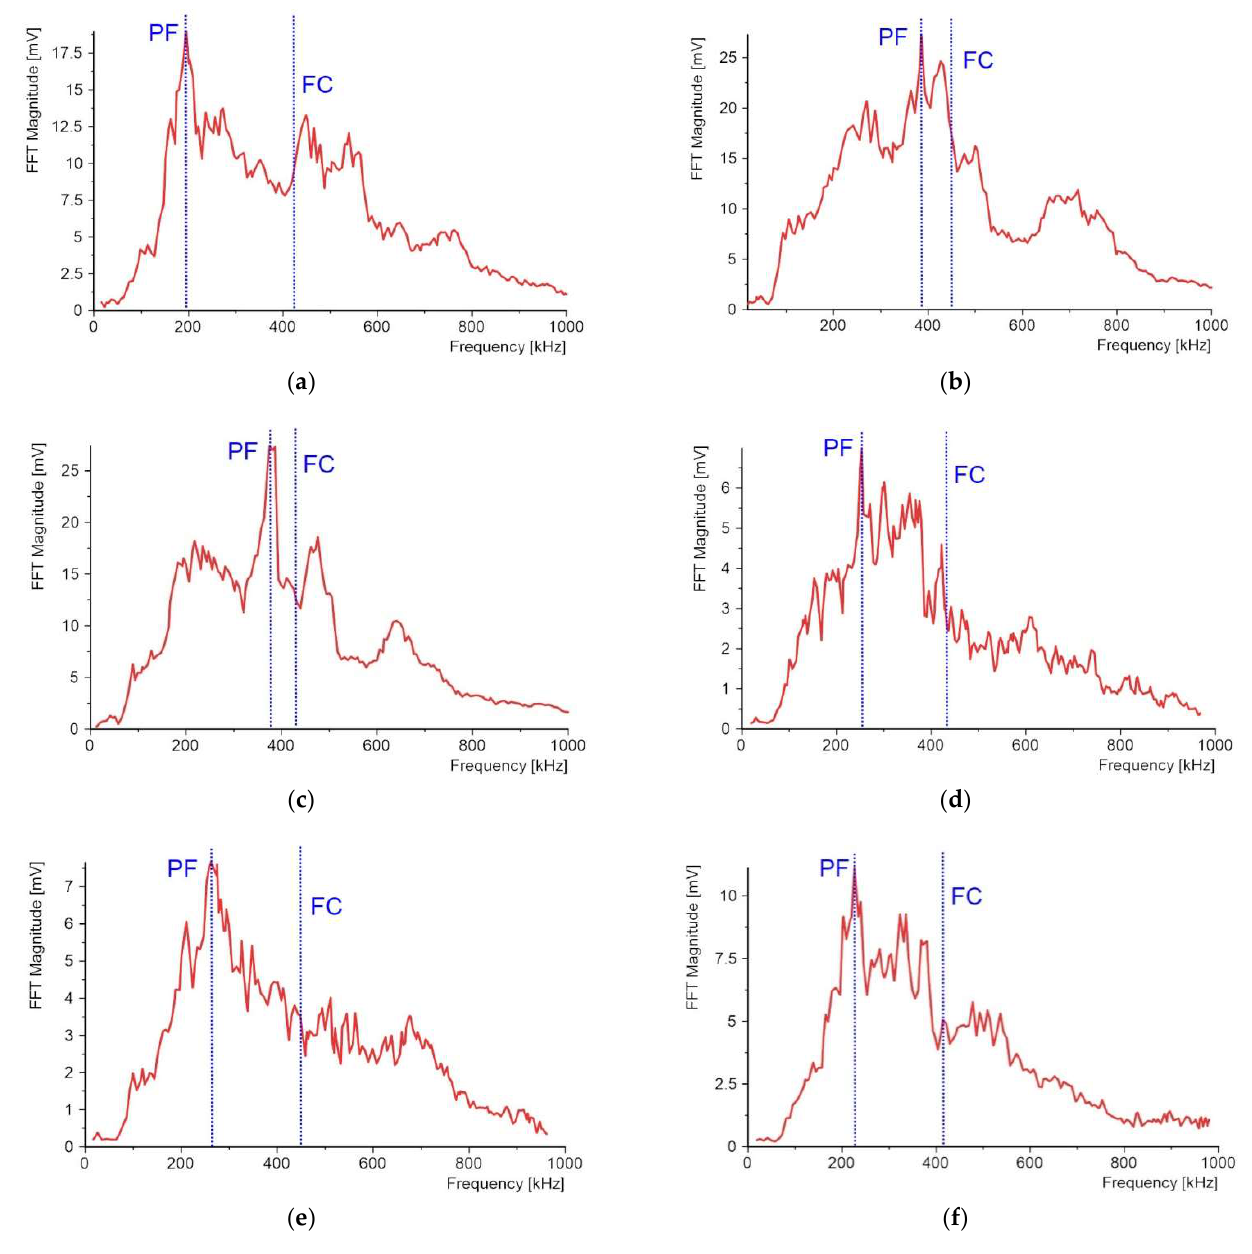
Figure 19. kHz to 452 kHz, so the FC is not a good parameter to characterize the damage of the PL Figure 19. Frequency spectra: PF and FC: ( a ) copper powder; ( b ) quartz sand powder; ( c ) Al2O3 coating made of powder. ( a ) copper powder, ( b ) quartz sand powder, ( c ) Al2O3 powder, ( d ) alumi- powder; ( d ) aluminum powder; ( e ) crystalline silica powder; ( f ) microballoon num powder, ( e ) crystalline silica powder, ( f ) microballoon powder.